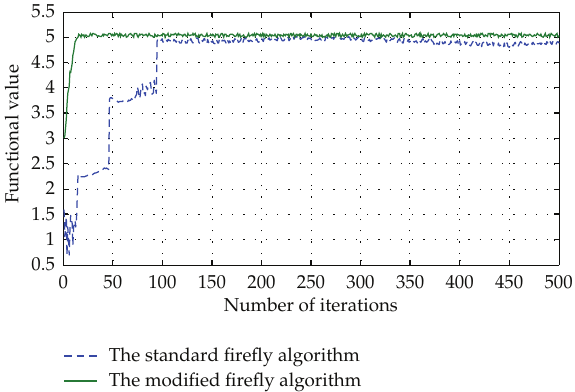
Figure 5: Simulation result of the fifth test